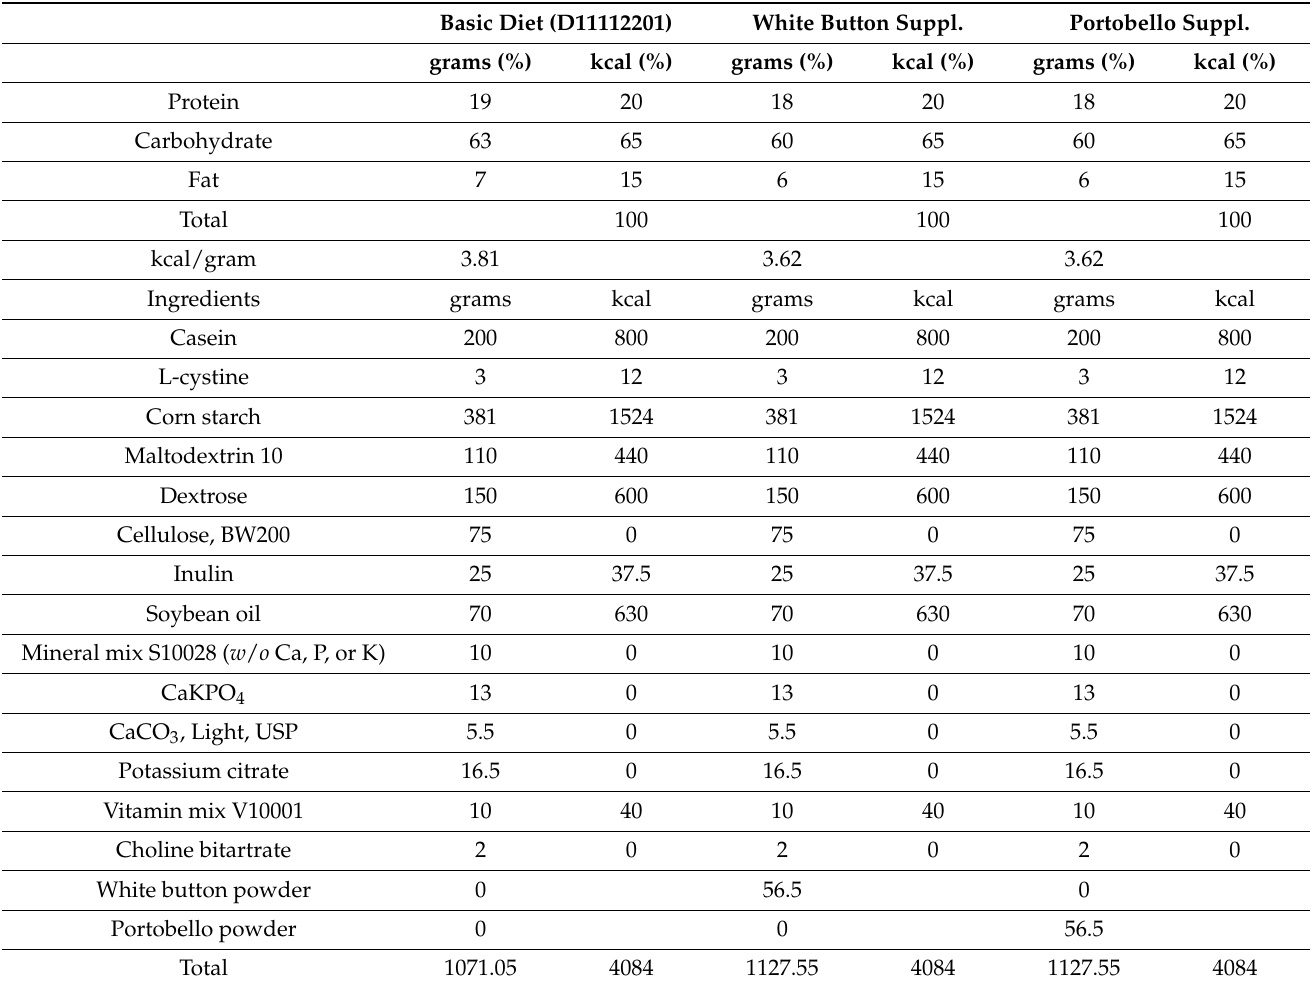
Table 1. Nutritional composition of the three diets used in this study. Basic Diet (D11112201) White Button